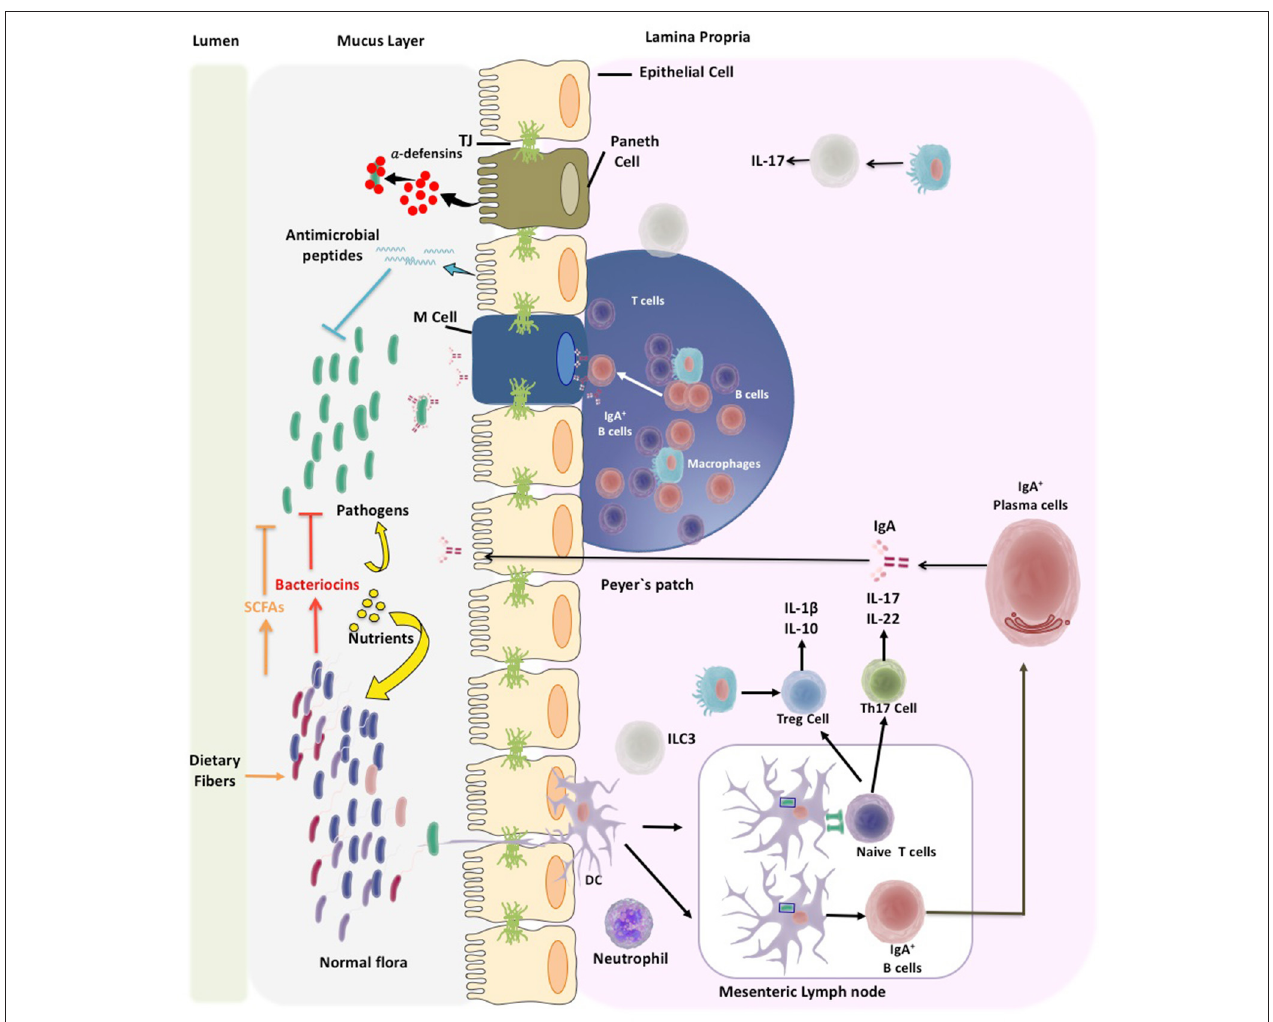
FIGURE 1 | Microbiota and pathogen control mechanisms of the gut immune system. The immune system of the gut has to deal with wide diversity of microbiota and pathogens. Thus, the immune system will help to establish a beneficial microbiota composition at the gut. Different mechanisms of the gut immune system have been discovered that control microbiota overgrowth and pathogens invasion. The gut immune system locates in the mucosa layer of the intestine mainly at the epithelium layer and Peyer’s patches at the lamina propia. Enterocytes, enteroendocrine cells, globet cells, and Paneth cells, located in the intestinal epithelial layer, secrete antimicrobial peptides like defensins. It has been shown that defensins are produced in the course of innate immune defense to activate the adaptive immune response. Another mechanism to control microbiota is the secretion of IgA which is accomplished by dendritic cells (DC). IgGA by interacting with bacteria impedes their adhesion and inhibits bacteria motility. DCs are localized at mucosal surfaces in antigen uptake sites and at inductive lymphoid tissue; they can directly sampling the normal flora and pathogenic bacteria. In the mesenteric lymph node DCs can promote differentiation of T cells, to regulate immune tolerance. Once T cells are activated they differentiate to T helper cells (Th), like Th1, Th2, or Th17 cells. Intestinal DCs will also regulate the differentiation of T cells to T regulatory (Treg) cells. Treg cells have the capacity to suppress the activation and proliferation of Th cells by the secretion of anti-inflammatory